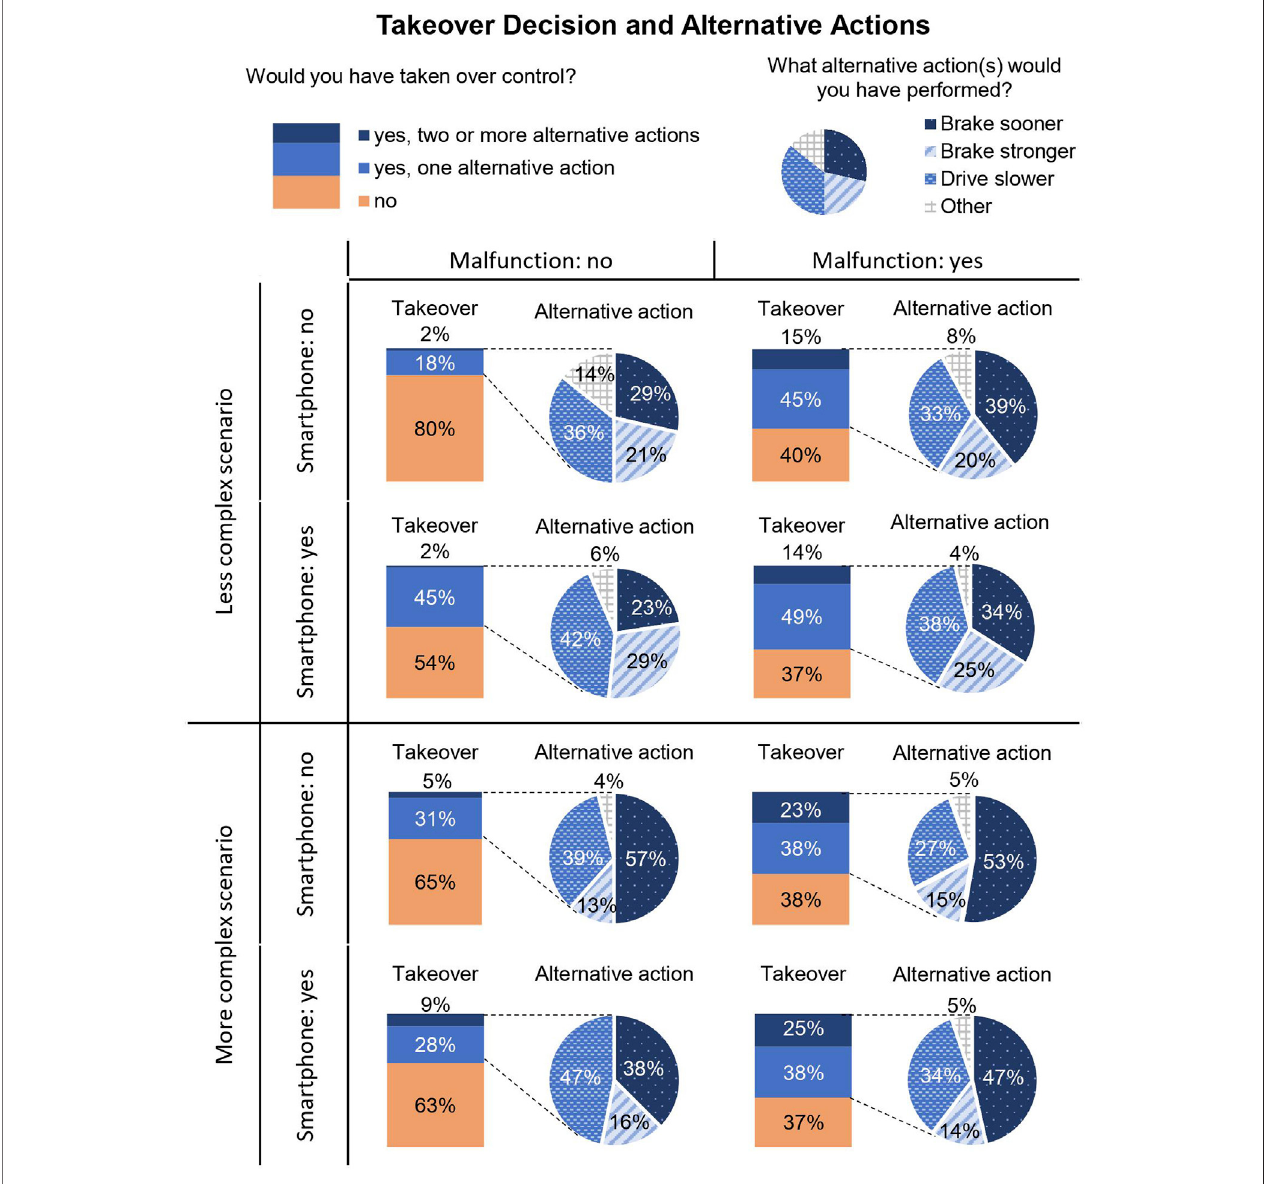
FIGURE 5 | Takeover decision and alternative actions by system malfunction , crossing pedestrian ’ s smartphone use and scenario complexity .